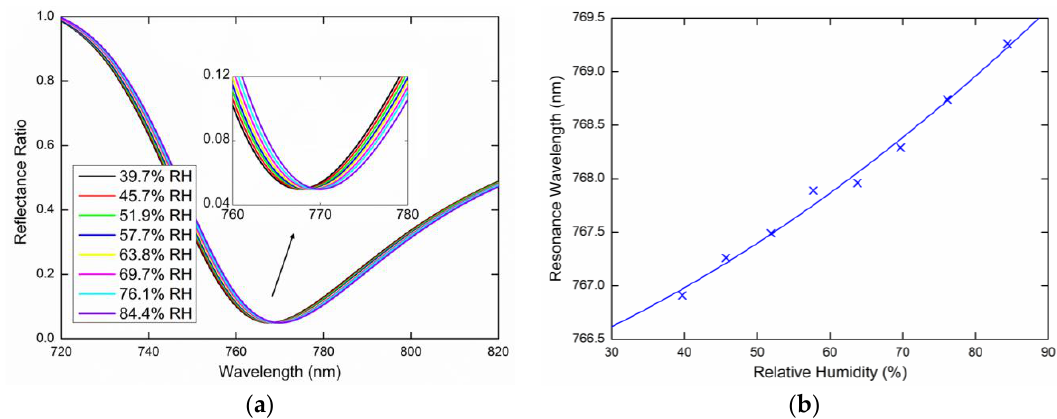
Figure 9. Measured spectral reflectance ratio 𝑅 𝑠 (𝜆) / 𝑅 𝑝 (𝜆) for the external angle of incidence 𝛼 = 20.6° ( a ), the resonance wavelength as a function of the RH with a linear fit ( b ).